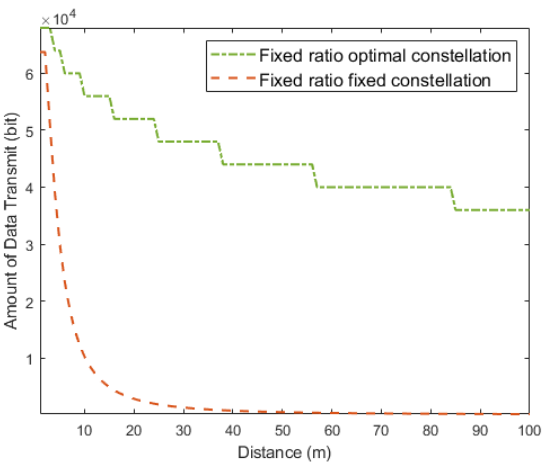
Figure 5. Fixed time ratio versus optimized time ratio at a fixed constellation. The experimental results in Figures 4 and 5 show that optimizing the constellation size and the time ratio can effectively increase the amount of transmitted data within a